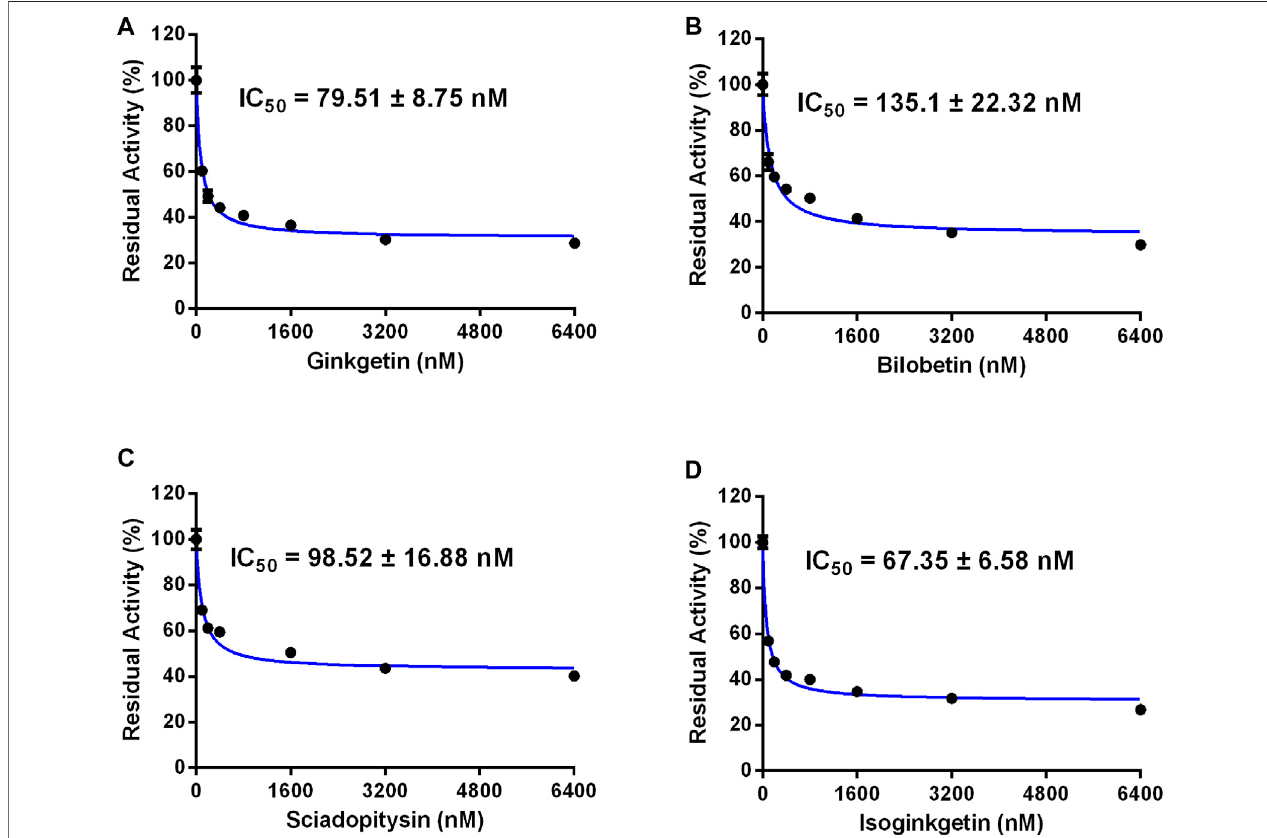
FIGURE 6 | Dose-inhibition curves of ginkgetin (A) , bilobetin (B) , sciadopitysin (C) and isoginkgetin (D) on CES2 using 4-MUA as the probe substrate in recombinant CES2. All data were shown as mean ± SD of triplicate assays.